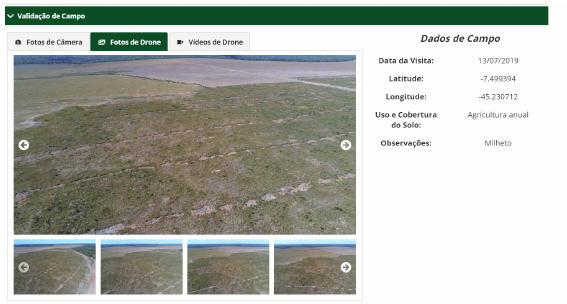
Figure 10. Deforestation Report presenting all the observations collected during the field validation.